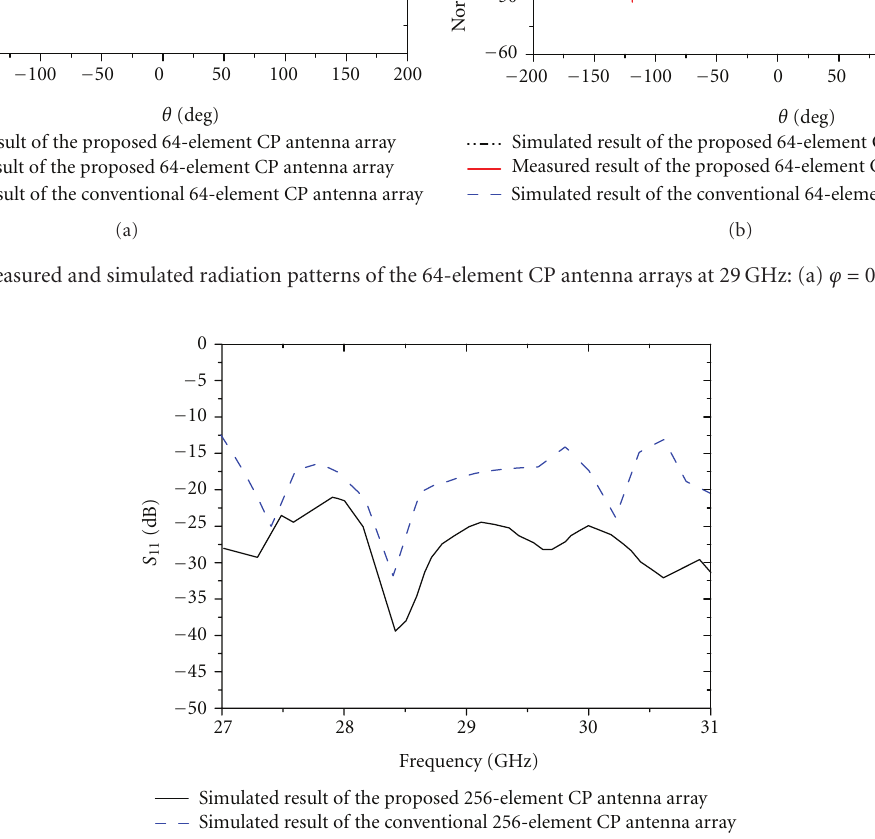
Figure 15: Simulated S 11 of the 256-element CP antenna